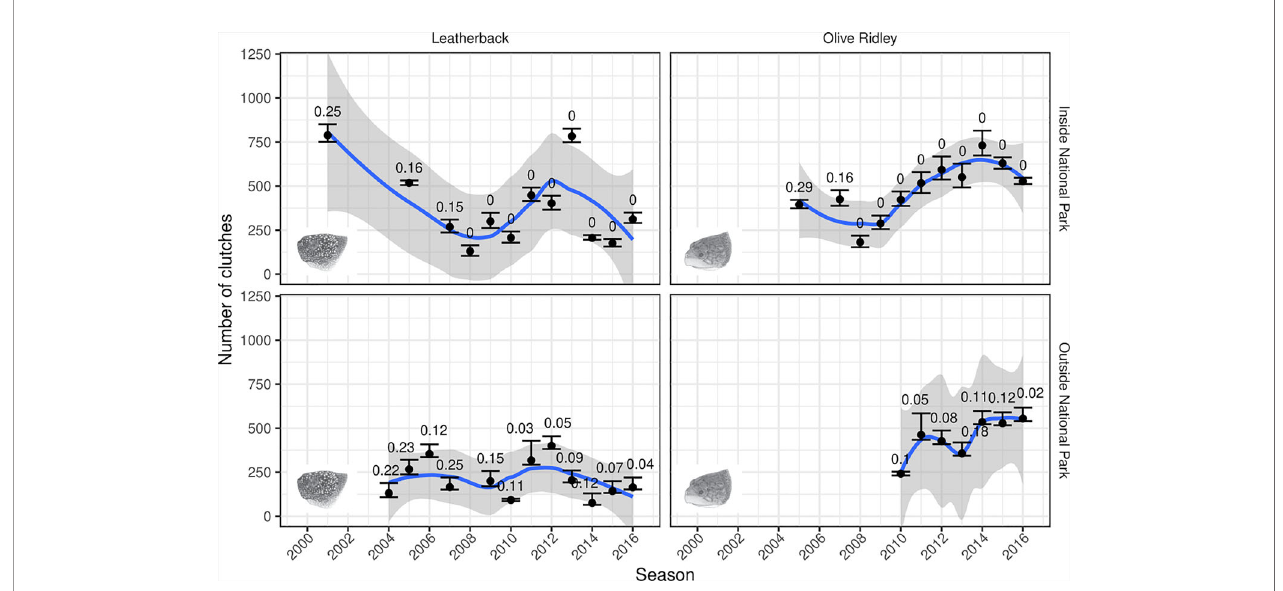
FIGURE 4 | Predictions for the number of clutches for leatherback and olive ridley turtles each season between 2000/2001 and 2016/2017 outside and inside the national park. For each panel, the points correspond to the posterior predictive mean estimates for the total number of clutches in that season, aggregated across all sites, with the error bars corresponding to the 95% prediction intervals. The number above the error bars correspond to the proportion of the clutches estimated in each season. We have removed any season with a posterior mean of > 30% of the total clutches being estimated. The trend lines correspond to loess-smoothed fi ts through the posterior means, with the grey ribbons depicting the 95% con fi dence intervals for the smoothed fi